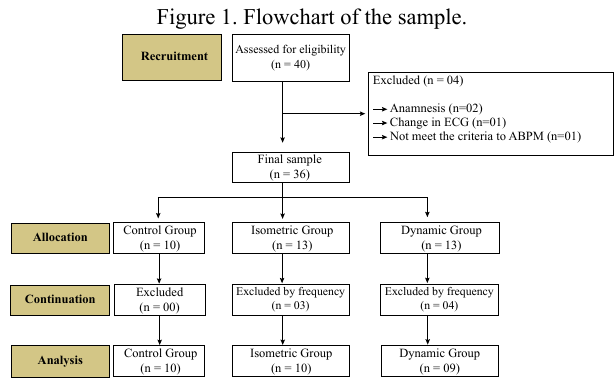
Figure 1. Flowchart of the